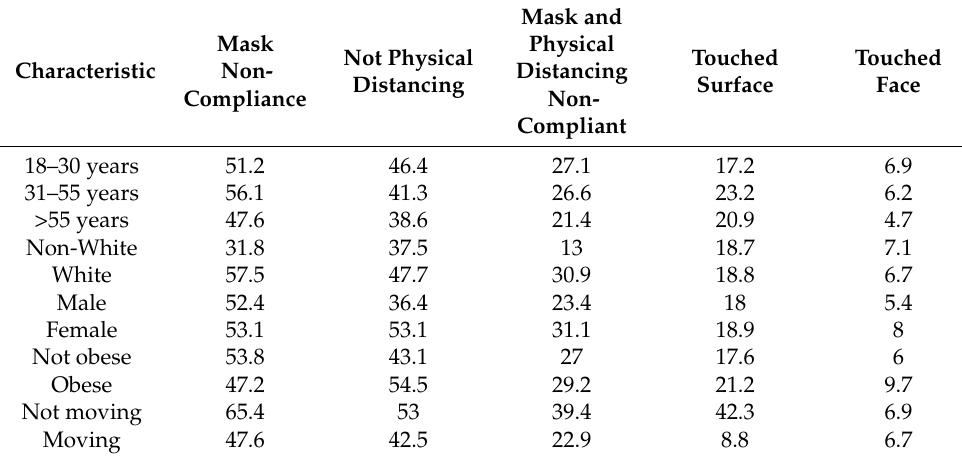
Table 6. COVID-19 transmission behaviors by